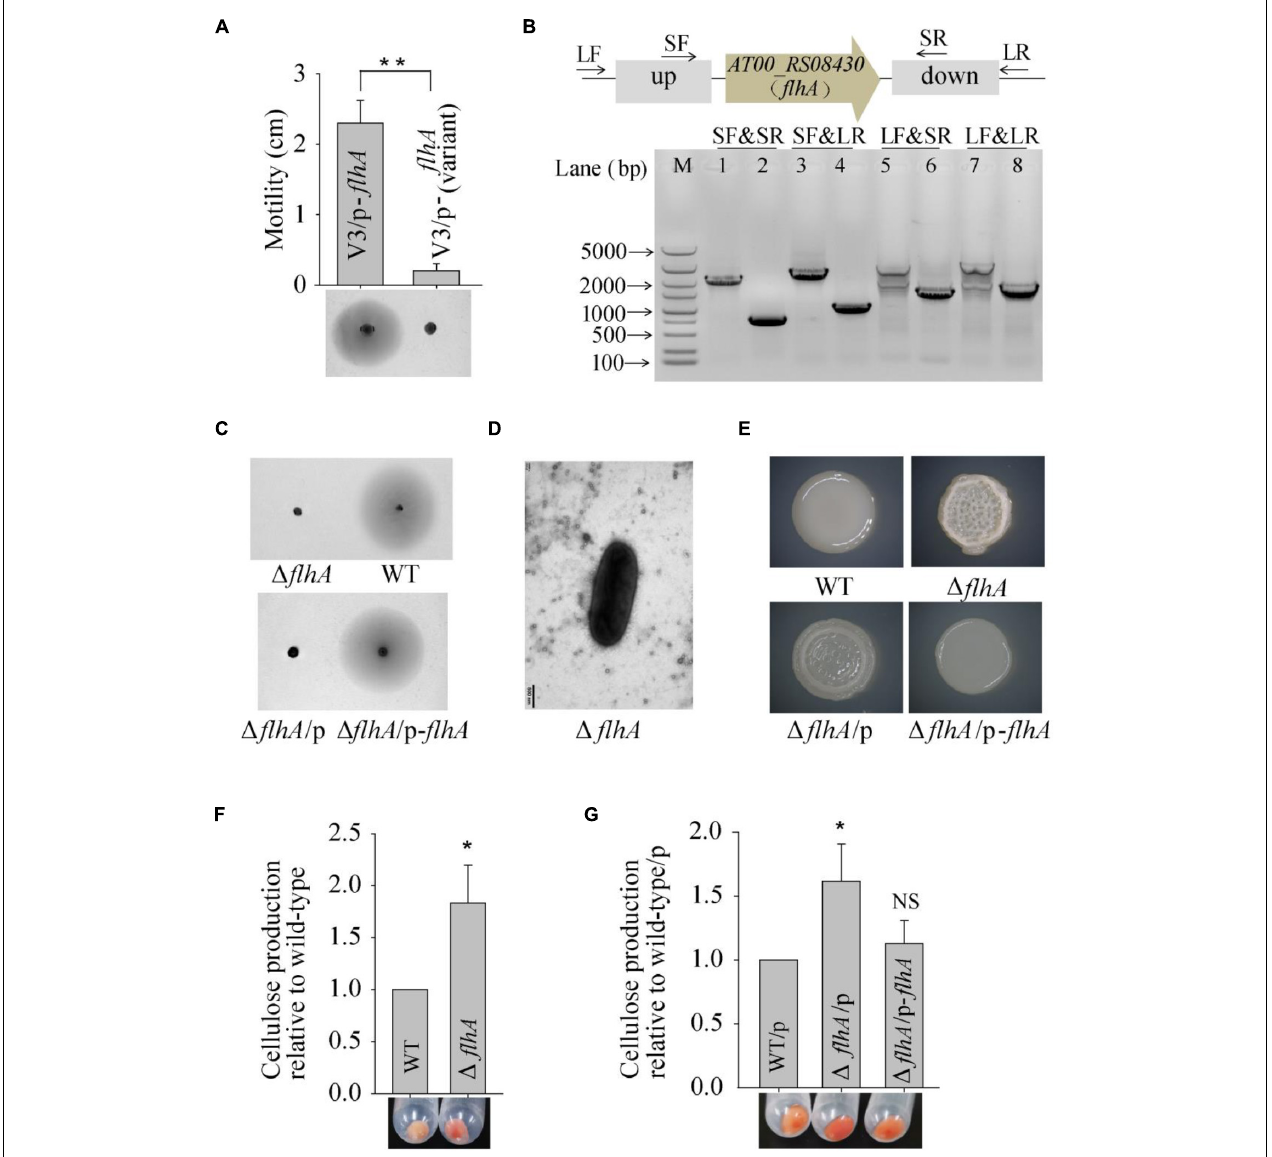
FIGURE 3 | Spontaneous mutation in flhA causes the phenotype of the V3 wrinkled variant. (A) Swimming motility of the V3 variants complementing the flhA gene was examined by culturing on semisolid 2216E agar plates containing 15 µ g/mL chloramphenicol for 20 h. (B) In-frame deletion of flhA in P. lipolytica wild-type strain was confirmed by PCR using four primer sets (SF&SR, SF&LR, LF&SR, and LF&LR) flanking the open reading frame of flhA (up panel). M indicated marker. Lanes 1, 3, 5 and 7 used DNA from the wild-type strain, and lanes 2, 4, 6 and 8 used DNA from the flhA mutant strain. (C) Swimming motility of the wild-type and (cid:49) flhA mutant strain and its complementation strain. (D) Morphology of the (cid:49) flhA mutant strain examined by transmission electron microscopy. (E) The colony morphologies of the wild-type and (cid:49) flhA mutant strain and its complementation strains. (F) Cellulose production by the wild-type and (cid:49) flhA mutant